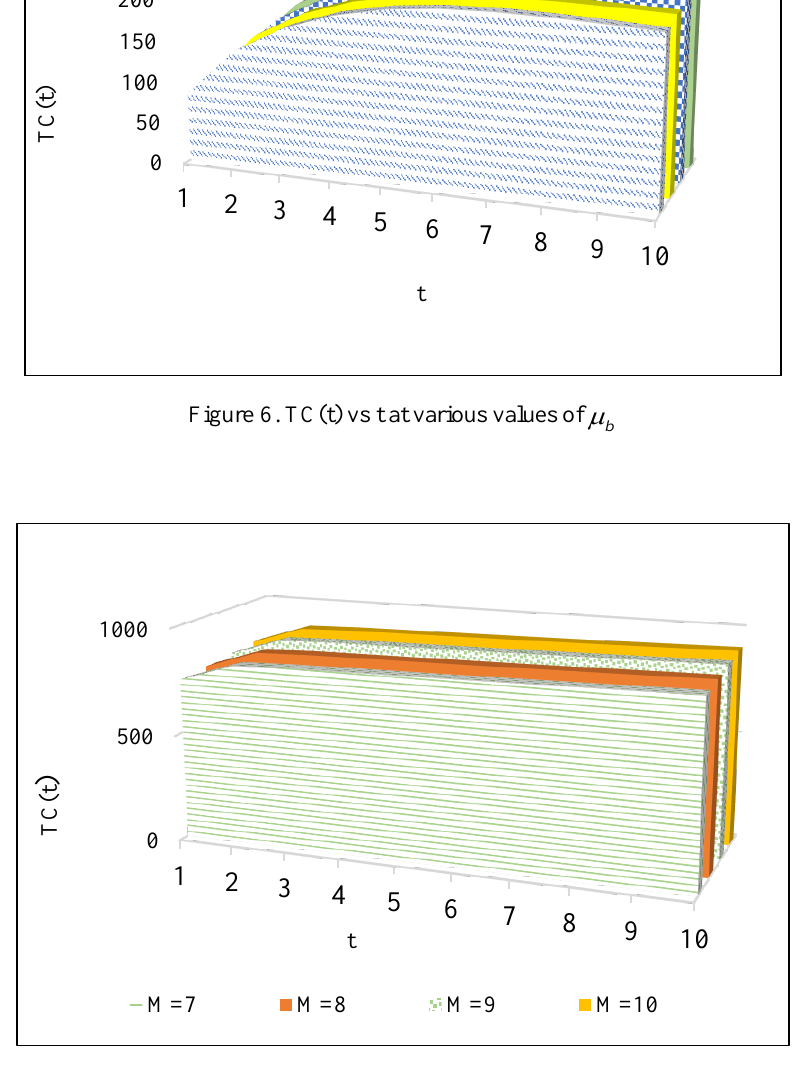
Figure 7. TC(t) vs t various values of